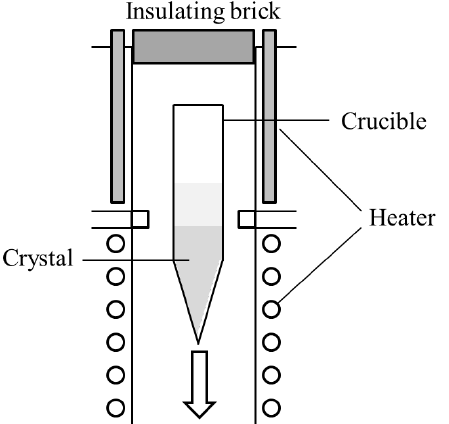
Figure 1. Schematic set-up of the Bridgman growth